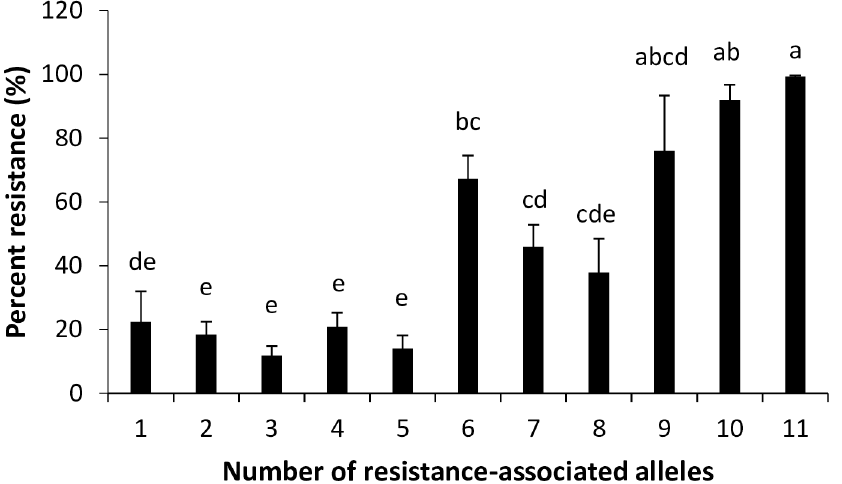
Fig 6. Number of favorable alleles for 6BS haplotypes and mean percentage of resistance to infection by UI Hessian fly population. Bars with the same letter are not significantly different at P < 0.05 (Tukey-Kramer HSD). Each value is the mean ± standard